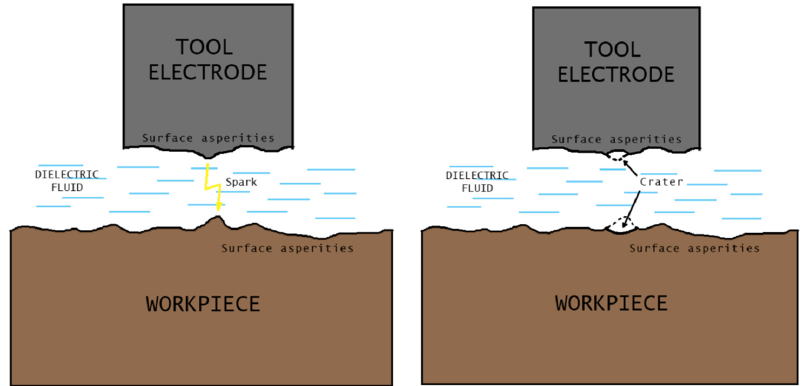
Figure 9. Basic principle of EDM.